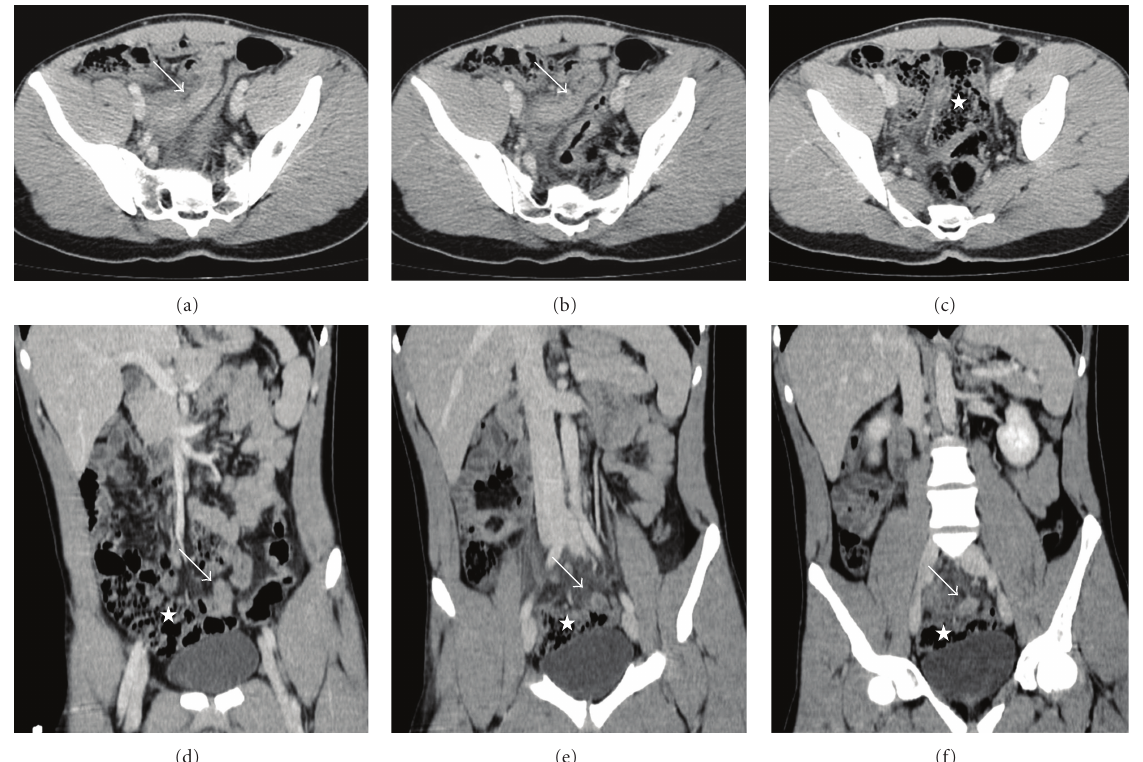
Figure 2: Axial (a–c) and coronal (d–f) CT images demonstrate pelvic location of the caecum (star). 3 consecutive axial and coronal CT images demonstrate 16 mm diameter tubular structure posterior to the caecum surrounded by inflamed mesenteric fat consistent with appendicitis (white